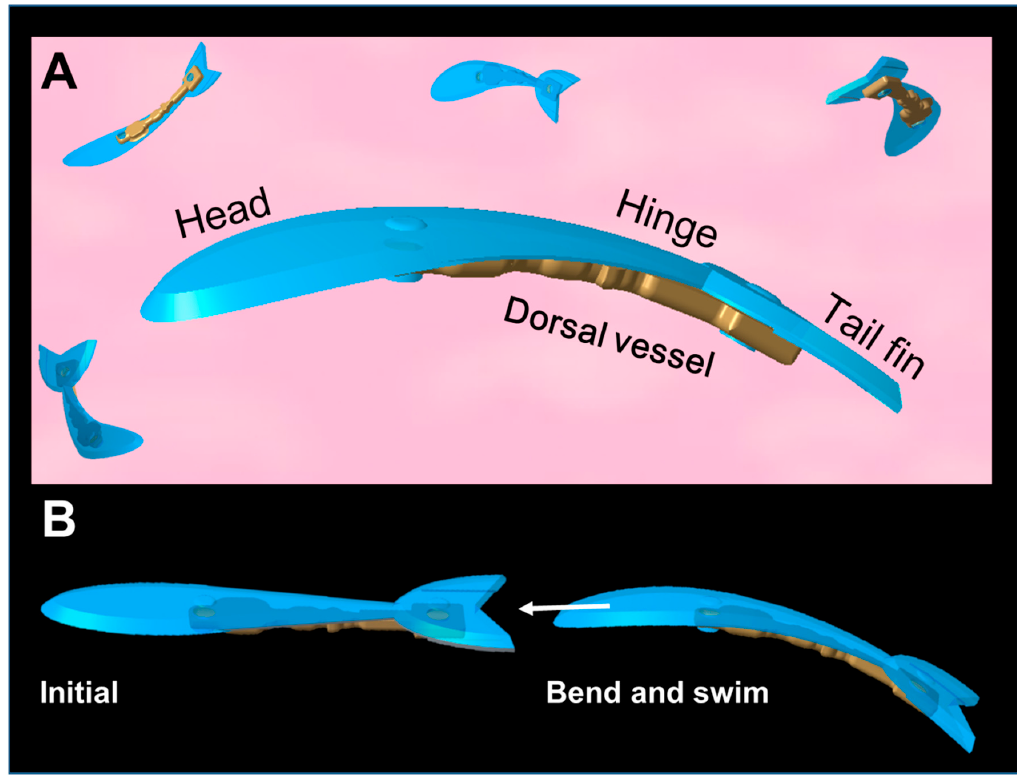
Figure 1. ( A ) Schematic views of an insect muscular tissue-powered swimming robot. The body of the swimming robot can be separated into the head, hinge, and tail fin parts. ( B ) The two ends of the DV are fixed to the head and tail fin of the robot body, and when the DV contracts, the robot bends and pulls away from the solution, thereby moving forward.